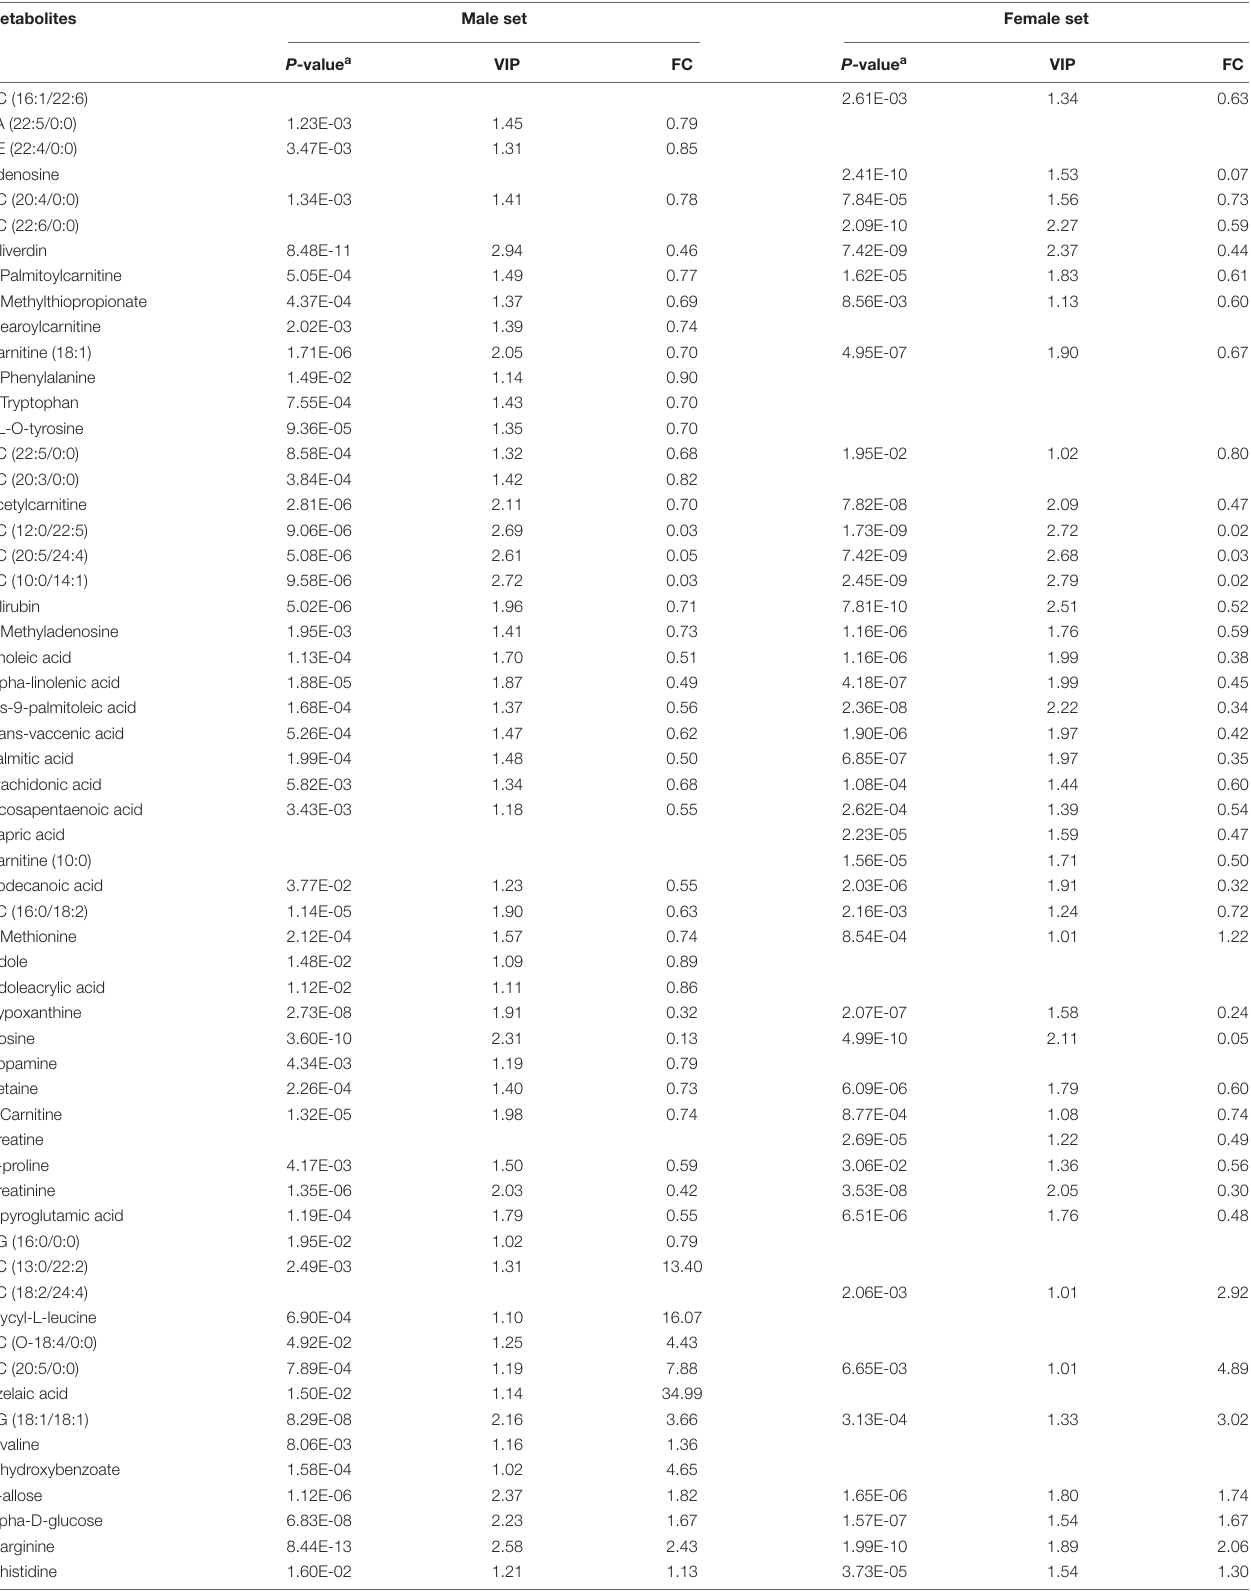
TABLE 2 | Identified differential metabolites in both male and female